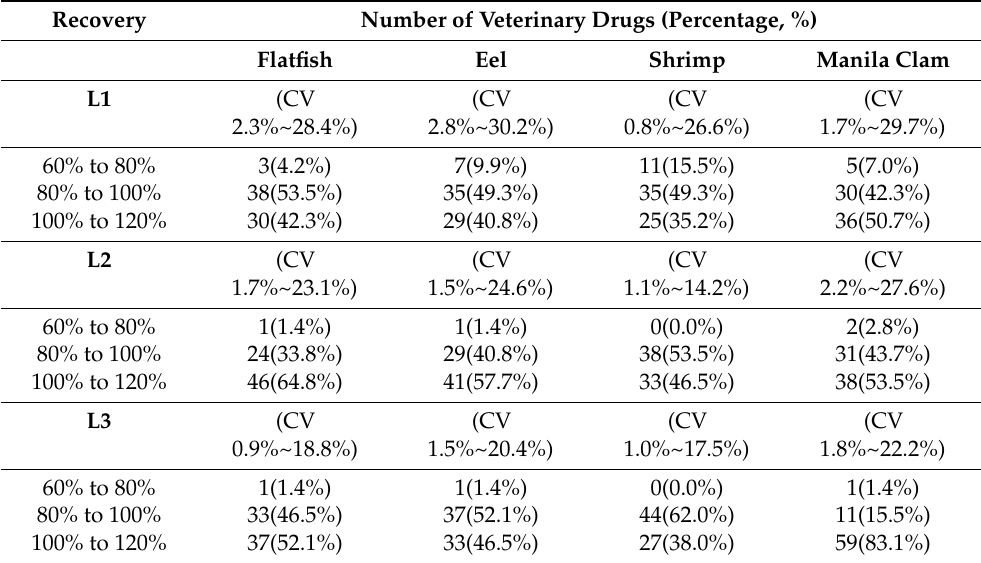
Table 1. Summary of method validation parameters; recovery and coefficient value (CV) for the 71 target veterinary drugs ( n =